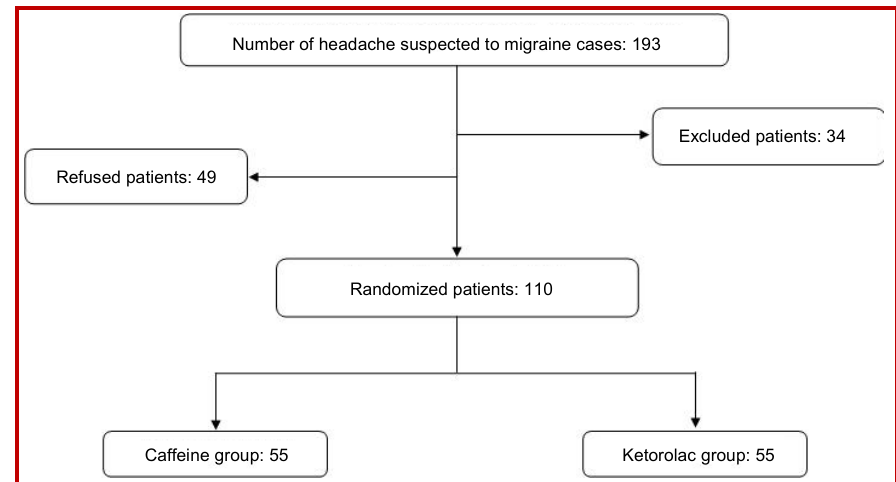
Figure 1: Enrolment of